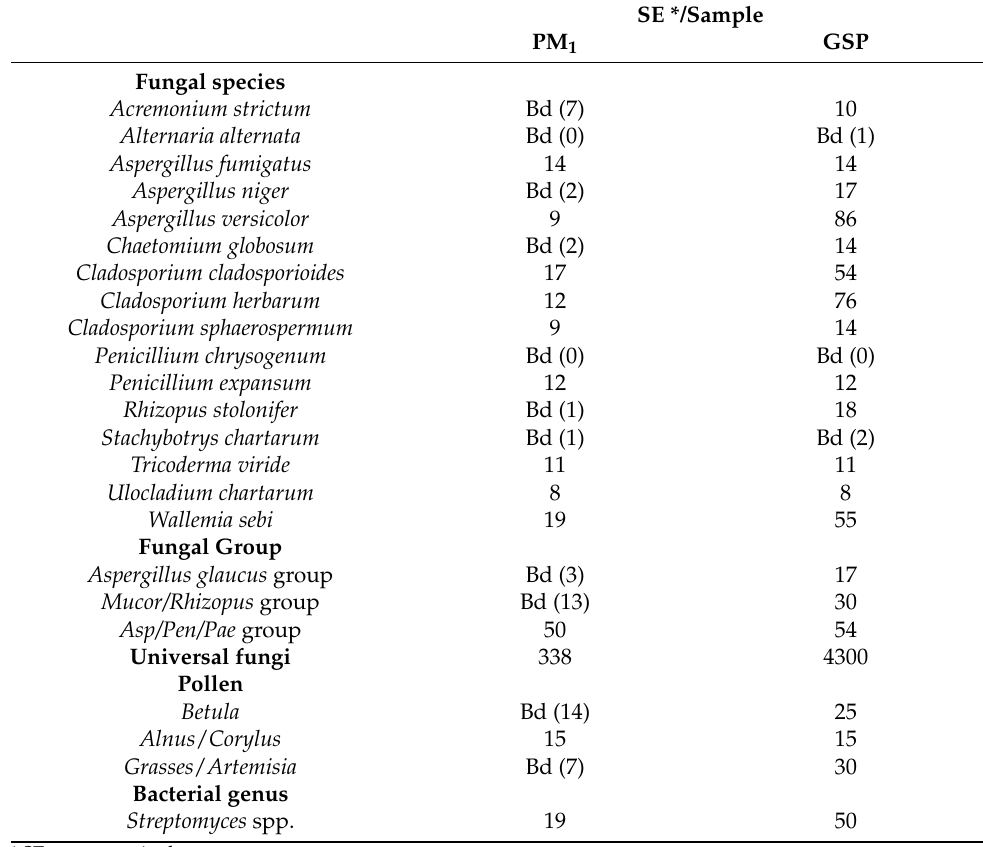
Table A1. The lowest value considered as positive for each organism in PM 1 and GSP samples, and in brackets the highest measured value for organisms below the detection